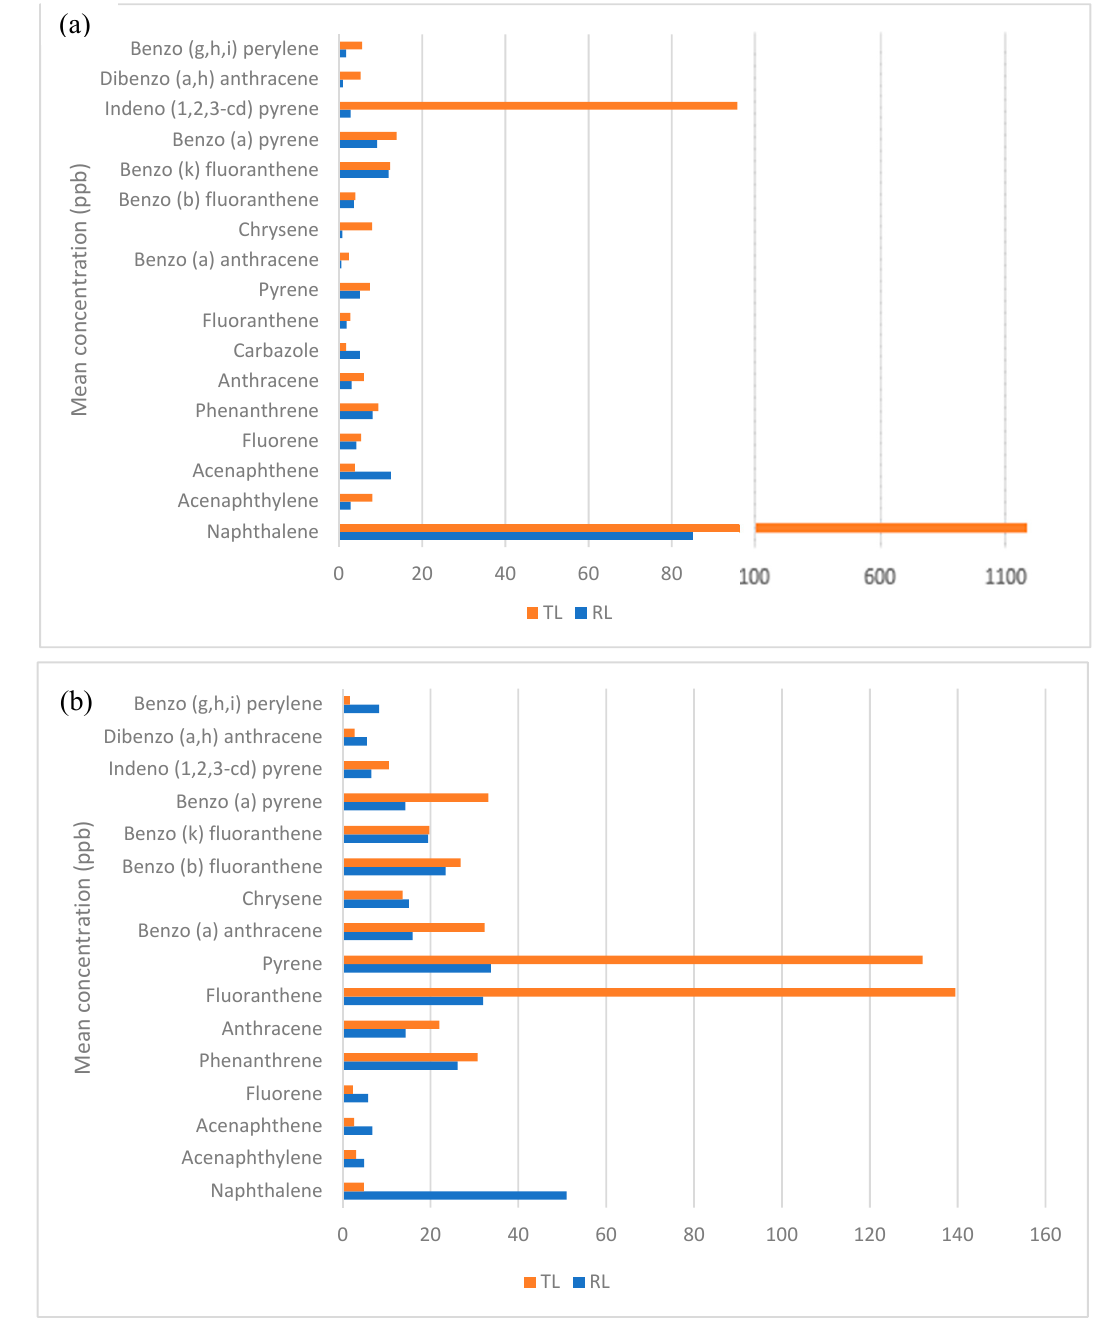
Figure 8 . ( a , b ): PAH in raw and treated leachate in the wet and dry seasons, respectively. Figure 8. ( a , b ): PAH in raw and treated leachate in the wet and dry seasons,